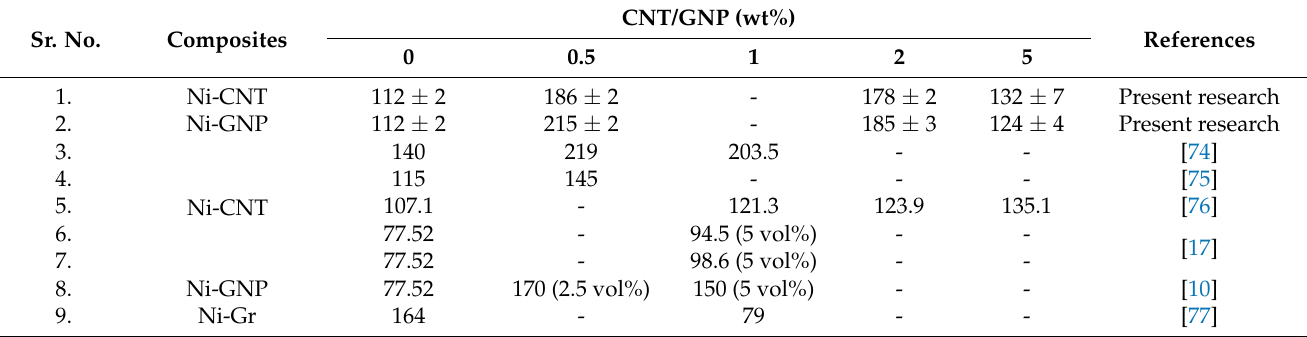
Table 2. Vickers microhardness value for pure Ni and Ni-CNT and Ni-GNP composites and other nickel MMCs with carbonaceous reinforcement from the